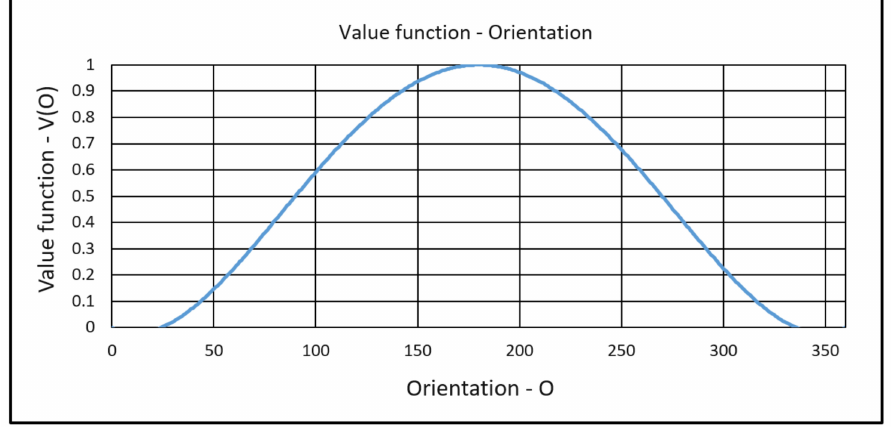
Figure 7. Graph of the value function of the orientation. Standardized orientation values are hereinafter referred to as O ’ j